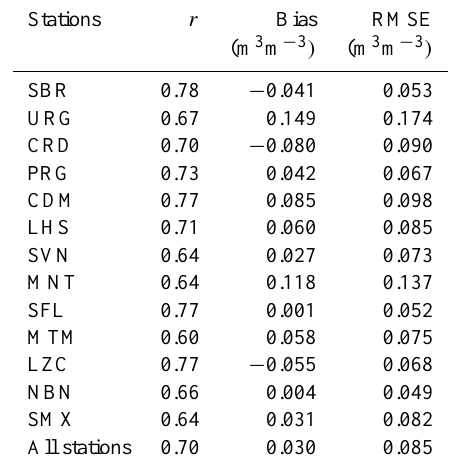
Fig. 3. Comparison between modelled SSM from the SIM model (red crosses) and in situ SSM (black dots) for four stations of the SMOSMANIA network (Sabres, Urgons, Lahas, and L´ezignan- Corbi`eres – SBR, URG, LHS, LZC, respectively) over a two year period (2007–2008).